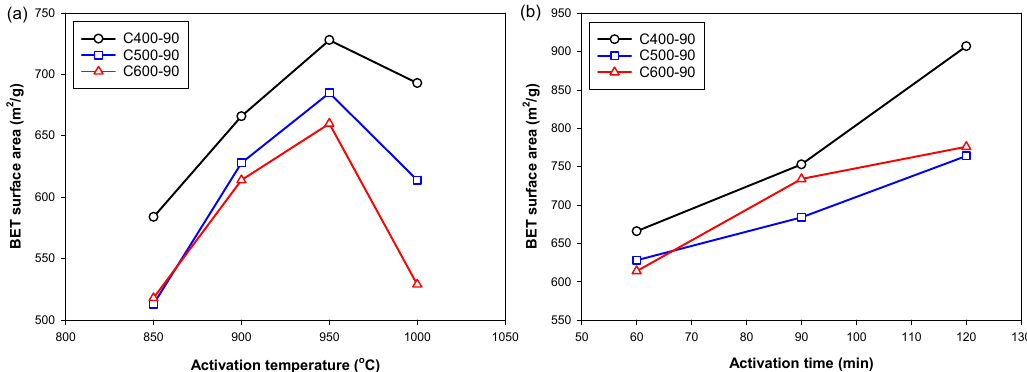
Figure 8. Effects of activation temperature and activation time on BET surface area of activated carbon prepared from chars carbonized at different temperatures (400, 500, and 600 ◦ C) for ( a ) activation temperatures were varied from 850 to 1000 ◦ C while the activation time was kept constant at 60 min and ( b ) activation times were varied from 60 to 120 min while the activation temperature was kept constant at 900 ◦ C.